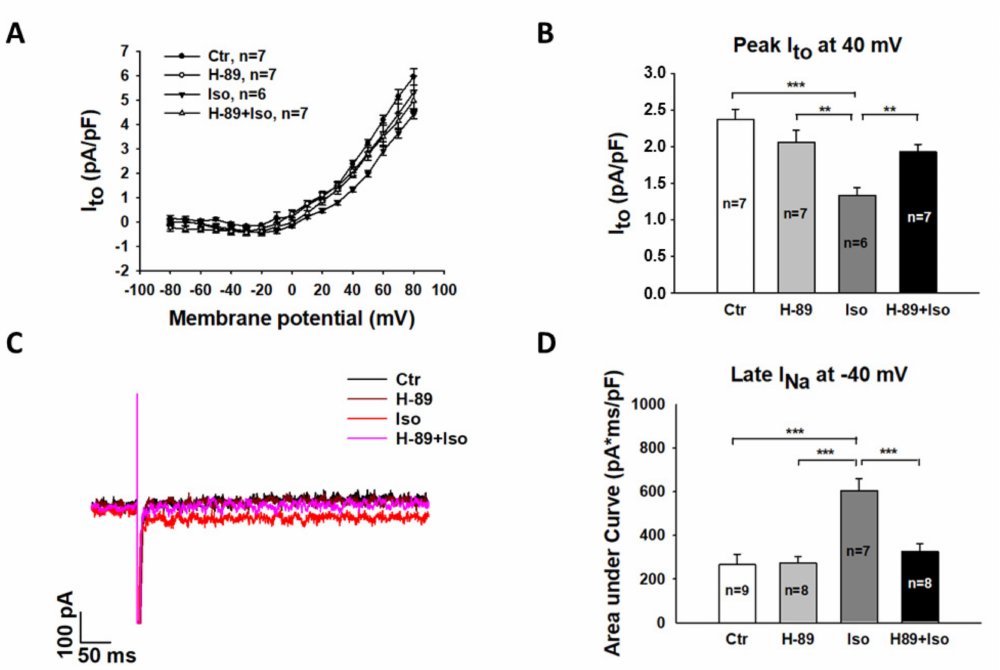
Figure 8. A PKA blocker attenuated the toxic effects of isoprenaline on transient outward currents (I to ) and late sodium currents in hiPSC-CMs. “Ctr” represents data from hiPSC-CMs treated with vehicle. “H-89” represents data from hiPSC-CMs treated with H-89. “Iso” represents data from hiPSC-CMs treated with a high concentration of Iso. “H-89+Iso” represents data from hiPSC-CMs treated with H-89 and a high concentration of Iso. ( A ) I–V curves of I to in cells of each group. ( B ) Mean values of peak I to at 40 mV in cells of each group. ( C ) Representative traces showing late I Na at − 40 mV in cells of each group. ( D ) Mean values of late I Na at − 40 mV in cells of each group. The late I Na was measured as the area under the current curve to zero line from 300 ms to 350 ms. Data are presented as mean ± SEM and analyzed by one-way ANOVA with Holm–Sidak post-test. The cell number of every experimental group is given as “n”. ** p < 0.01, *** p <